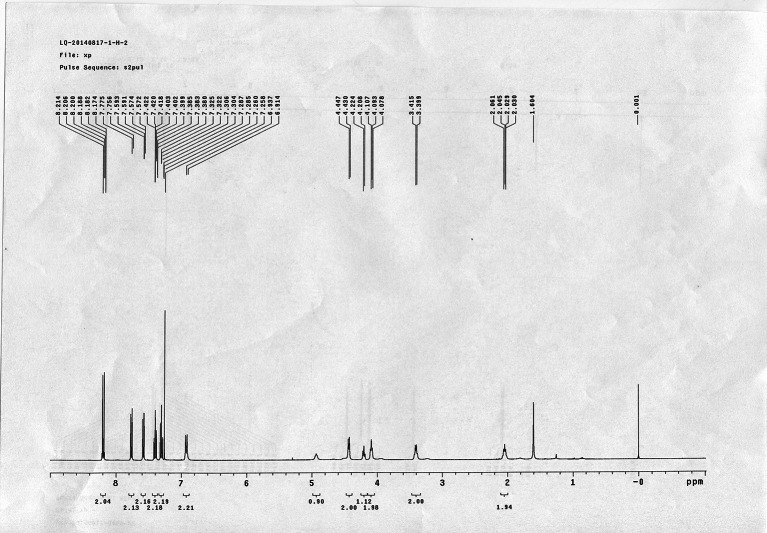
1H NMR spectra of compound 20.